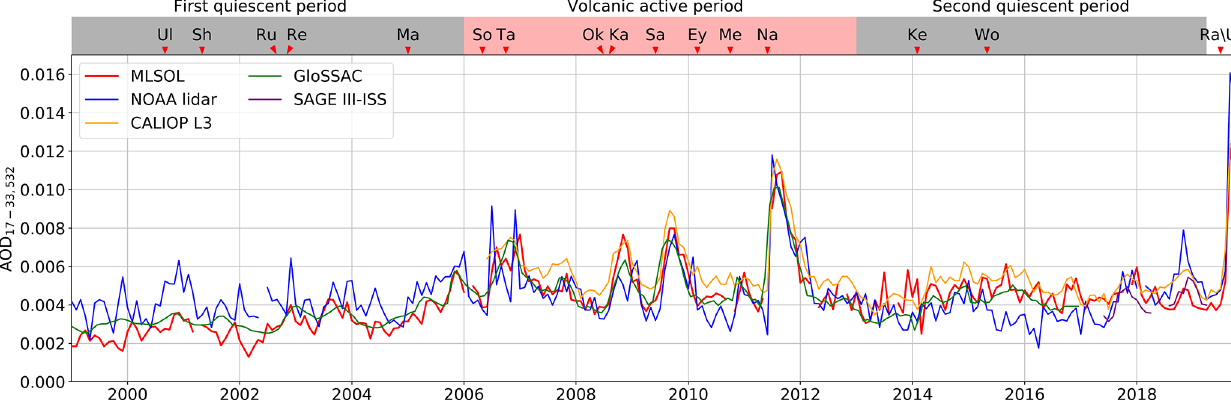
Figure 14. Monthly averaged time series of stratospheric AOD (17–33km) derived from MLSOL (red), NOAA lidar (blue), CALIOP (orange), GloSSAC (green), and SAGE III-ISS (purple) extinction